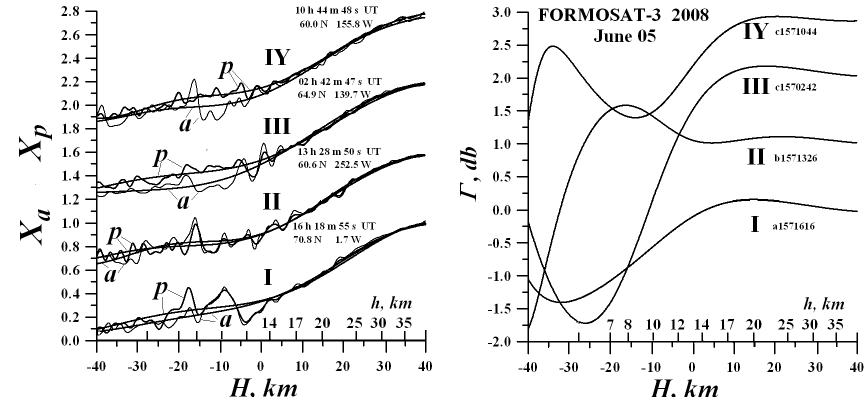
Figure 3. Left plot – Comparison of the refractive attenuations X a (h) and X p (h) (groups of curves I–IY). Each group consists of four curves. In each group thick and thin rough curves (marked by indices “p” and “a”) describe the experimental vertical profiles of X p (h) and X a (h) , respectively. Smooth curves in each group describe polynomial approximations of the altitudes dependences of X p (h) and X a (h) and are also highlighted by indices “p” and “a”, respectively. For convenience groups of curves II–IY are displaced by 0.6; 1.2; 1.8 units. Right – The total absorption (cid:48) corresponding to the refractive attenuations X a (h) , X p (h) measured at frequency F1 has been calculated from the smooth curves I–IY (marked by indices a,p in left panel). Curves II, III, and IY are shifted for comparison by 1, 2, and 3db, respectively.